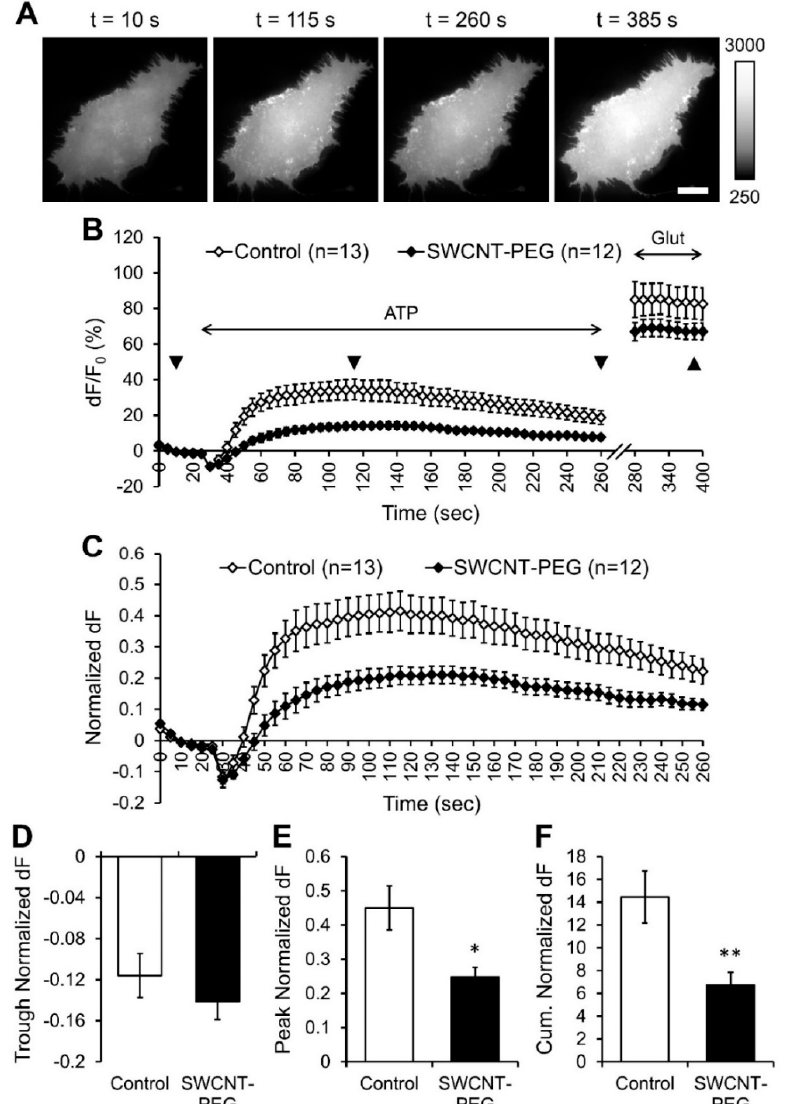
Figure 2. SWCNT-PEG solute inhibits the ATP-induced glutamate release from cultured mouse cortical astrocytes. ( A ) Individual frames from the time-lapse imaging of iGluSnFR (extracellular glutamate sensor) in a control astrocyte showing the changes in iGluSnFR fluorescence at selected time points (indicated with triangles in ( B )). Scale bar, 20 μ m. Gray scale is a linear representation of the fluorescence intensities of the pixels in the images, expressed in fluorescence intensity units (iu). ( B ) Time-lapse imaging of iGluSnFR fluorescence, reporting on the average extracellular glutamate levels at the plasma membrane of astrocytes in the absence and the presence of SWCNT-PEG solute (5 µ g / mL). ATP (100 µ M) was bath applied to stimulate Ca 2 + -dependent exocytotic glutamate release from astrocytes. Exogenous glutamate (Glut; 100 µ M) was bath applied to saturate the iGluSnFR fluorescence at the plasma membranes of astrocytes. The horizontal double-headed arrows indicate the times of addition of ATP and glutamate containing external solutions. Changes in iGluSnFR fluorescence are expressed as dF / F 0 (%) after background subtraction. Number of astrocytes studied in each condition is shown in parentheses. ( C ) Changes in the iGluSnFR fluorescence of astrocytes shown in B, normalized to their saturated glutamate response after the application of glutamate, expressed as the normalized change in iGluSnFR fluorescence, dF. Traces in B and C show means + SEMs. ( D – F ) Summary graphs showing the average trough ( D ), peak ( E ) and cumulative ( F ) normalized dF with SEMs. Asterisks indicate a statistical di ff erence compared to the control. Student’s t -test (pooled variances); * p < 0.05, ** p <